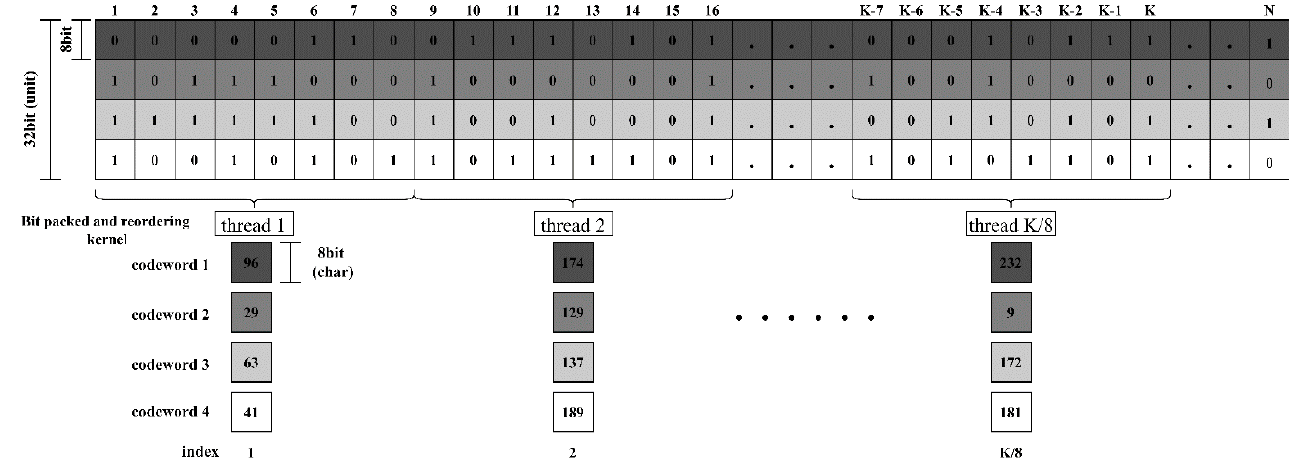
Figure 7. The process of the bit packed and reordering kernel.